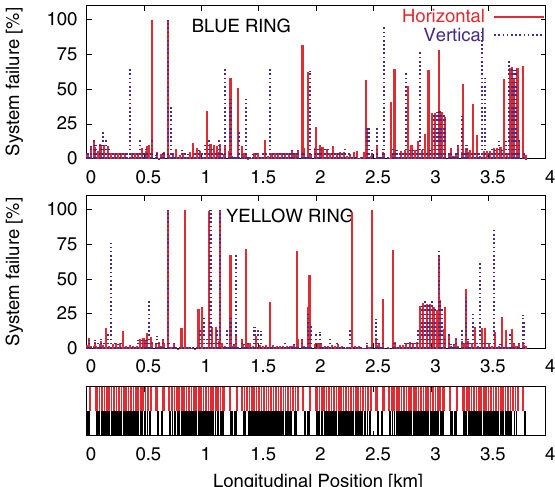
FIG. 13. (Color) Percentage of occurrences of system failure per BPM versus longitudinal location for run 2004. A repre- sentation of the lattice (dipoles in black and quadrupoles in red) is shown in the bottom graph.